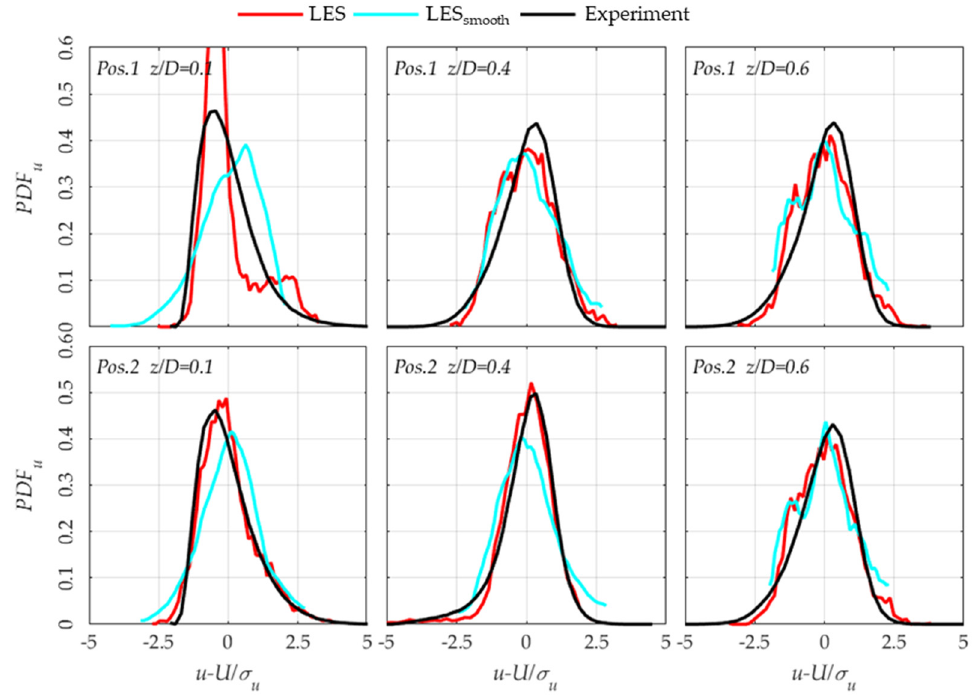
Figure 15. Probability density function of the longitudinal wind velocity.